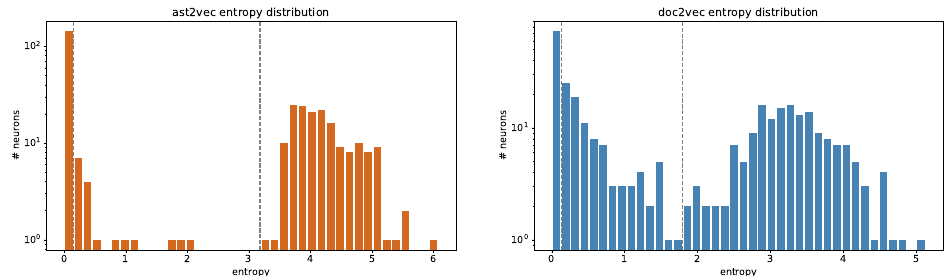
Figure 3. Distribution of the neurons’ entropies in the ast2vec ( left ) and doc2vec ( right ) models. Vertical dashed lines separate the three classes of neurons described in Section